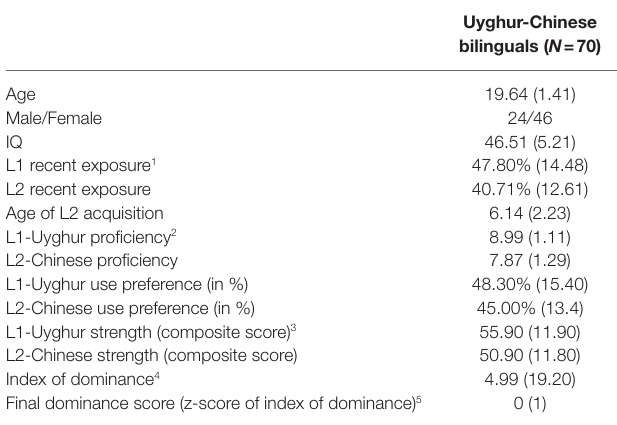
TABLE 1 | Language background and language dominance information of bilingual